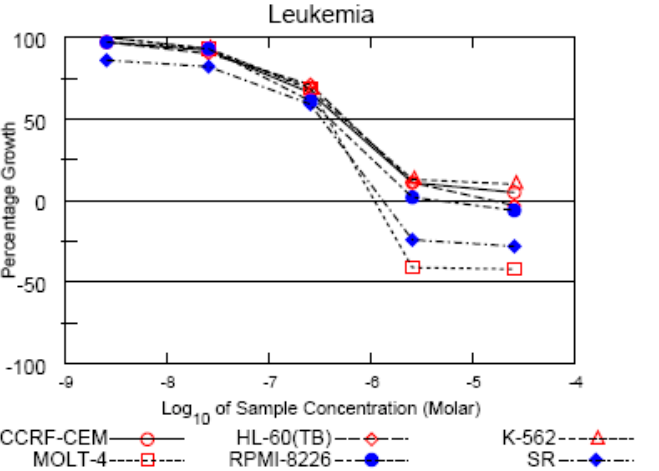
Figure 1. Data obtained from the NCI, showing that Leukemia MOLT4 has a negative GP = − 42 and SR cell line GP = − 28, after the addition of compound 3c .